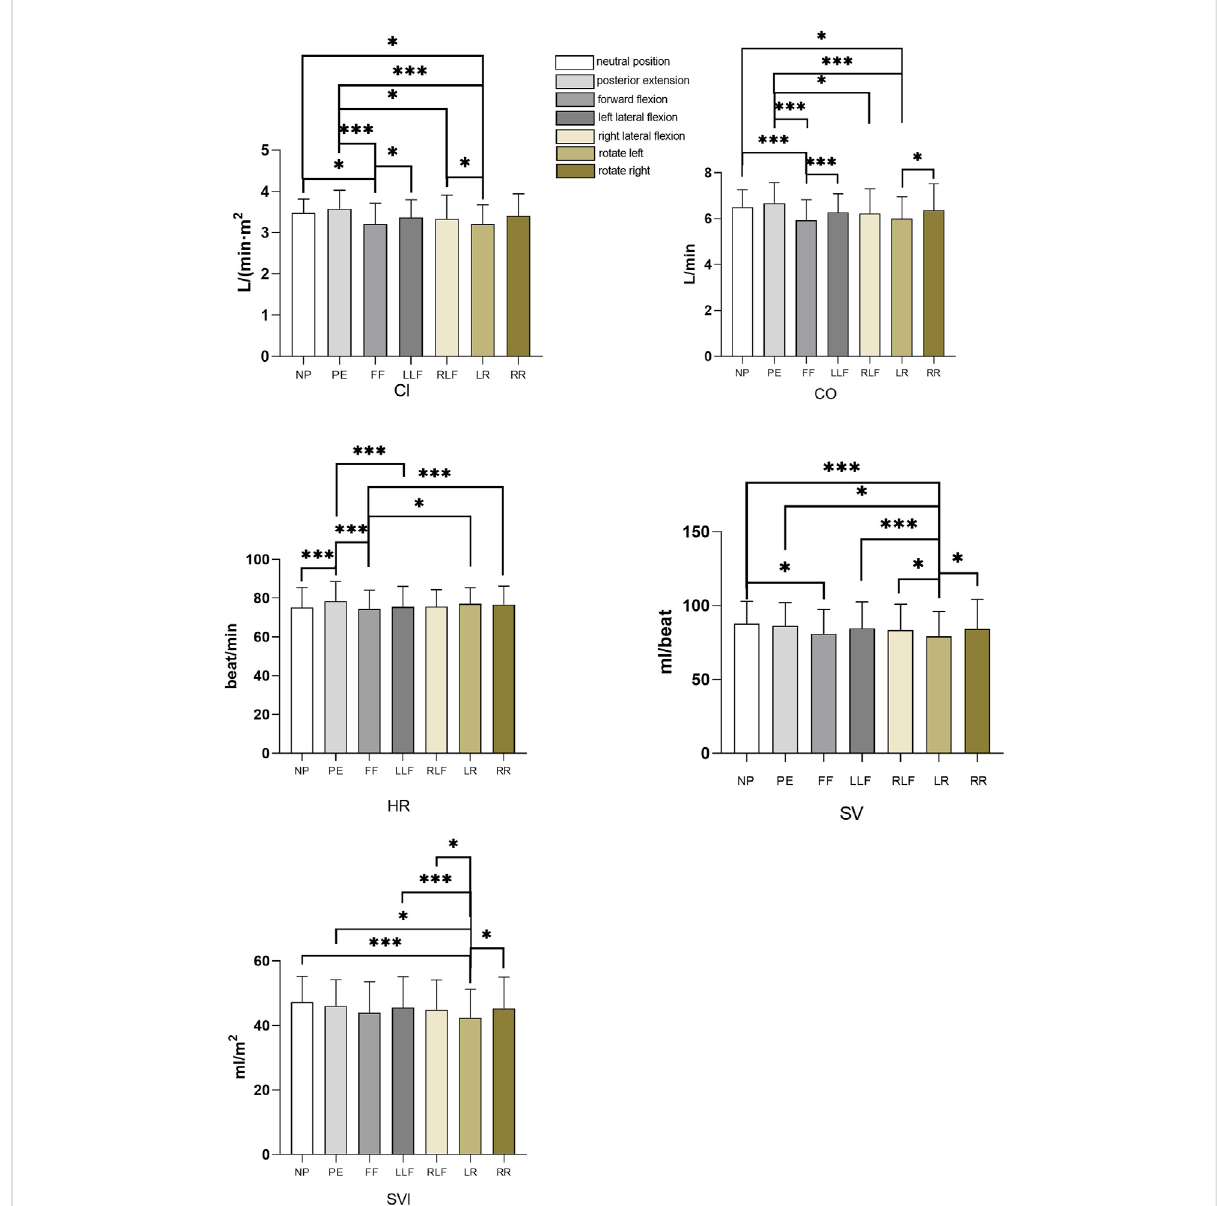
FIGURE 4 Histogram of cardiac index, cardiac output, heart rate, stroke volume and stroke index of seven postures. NP, neutral position; PE, posterior extension; FF, forward fl exion; LLF, left lateral fl exion; RLF, right lateral fl exion, LR, left rotation, RR, right rotation. * p < 0.05, *** p < 0.01.